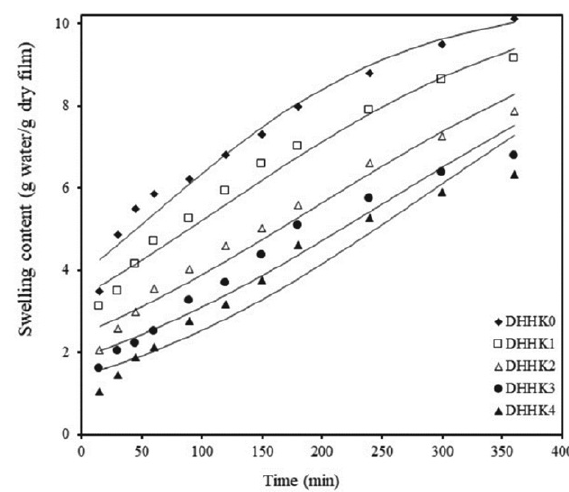
Figure 9. Fitting of the modified Lag phase sigmoid model of films of HPMC K100 M (H H ) matrix with varied kaolin swelling